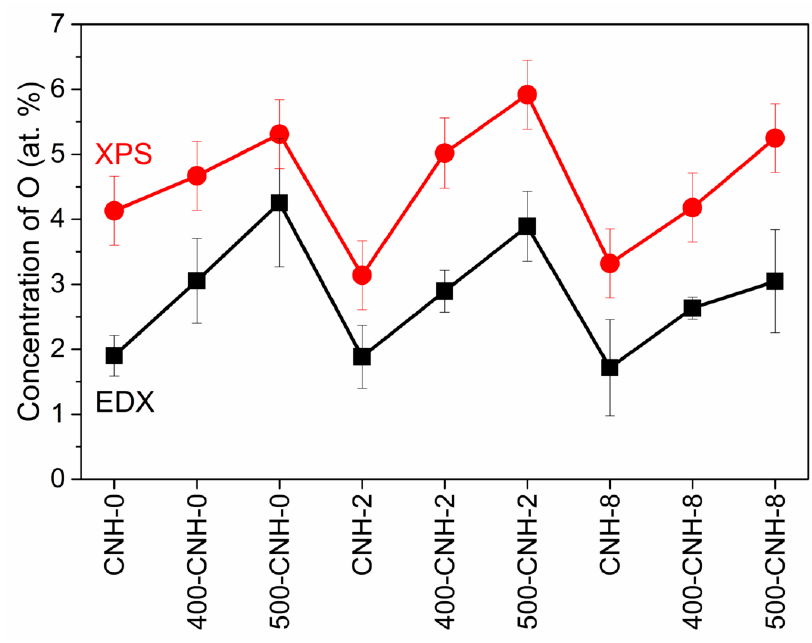
Figure 6. EDX and XPS concentration of oxygen in